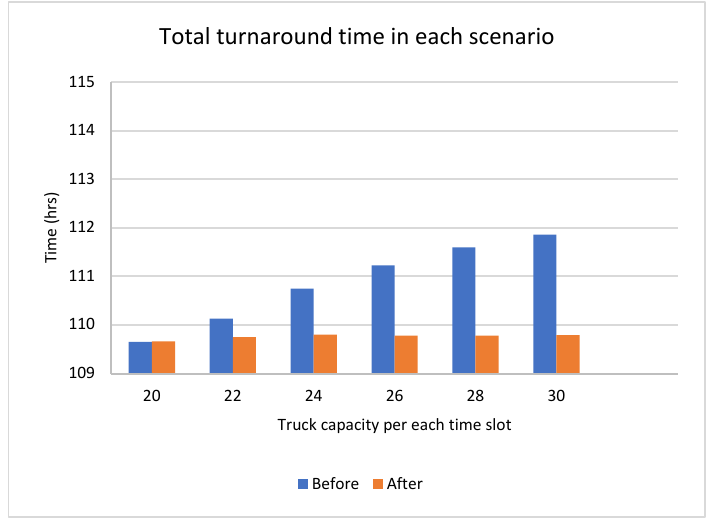
Figure 14. The total TTT before and after levelling the workload.